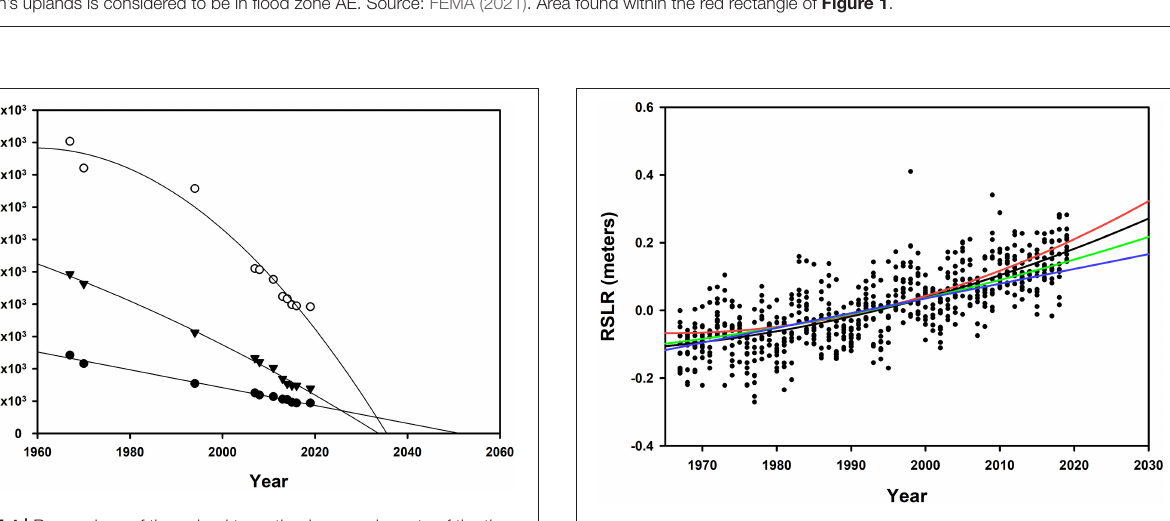
FIGURE 5 | Low (blue), mid (green), high (red) SLR curves of the USACE compared with the raw data of Sewell’s Point Tide Gauge (black) from 1967–2020. The equation for Sewell’s point raw data is y = 0.00005765x 2 – 0.223x + 216.869 ( r 2 = 0.57 and p < 0.05 for all